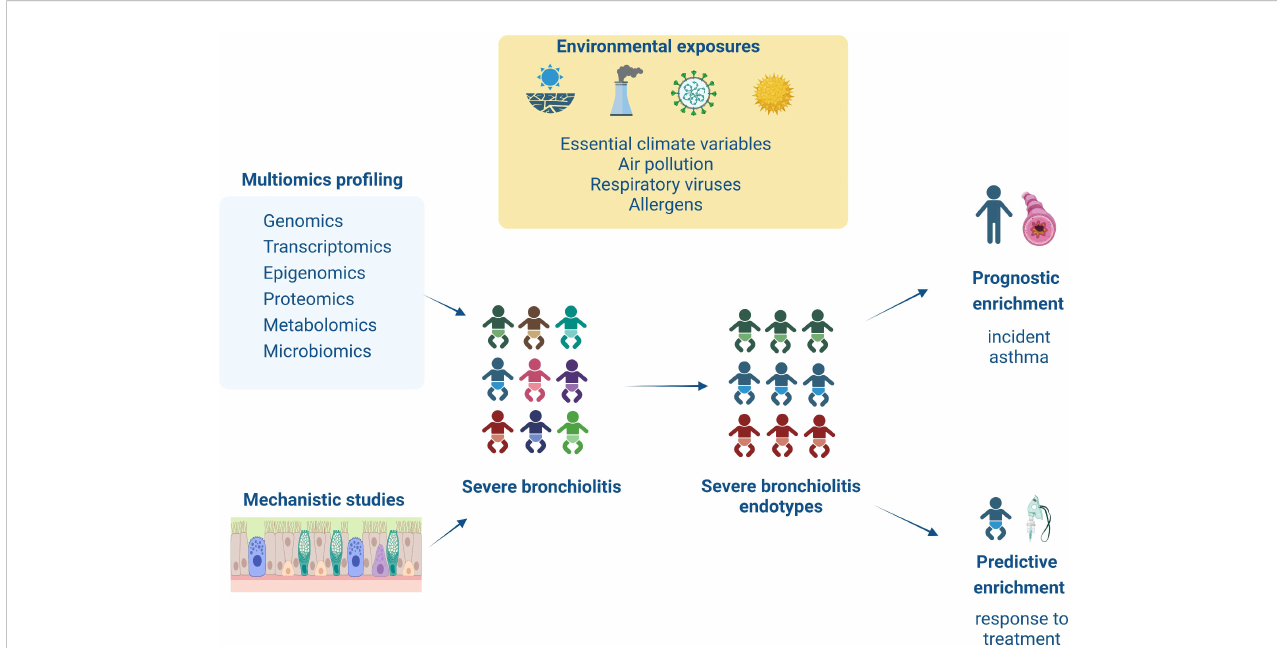
FIGURE 1 This fi gure summarizes the content of the articles collected on this Research Topic. Infants with severe bronchiolitis are at higher risk of having a severe and prolonged hospitalization and long-term respiratory sequelae (i.e., asthma). However, due to increased heterogeneity in clinical presentation and underlying pathology in severe bronchiolitis, we are still missing targeted treatments and sensitive biomarkers for asthma development. This Research Topic presents novel studies utilizing multiomics (i.e., genomic, transcriptomic, epigenomic, proteomic, and metabolomic) or mechanistic (i.e., in/ex vivo , in vitro ) approaches to explore in-depth severe bronchiolitis pathophysiology. These fi ndings help identify severe bronchiolitis endotypes that respond to targeted treatments (i.e., predictive enrichment) or are associated with increased risk for asthma development (i.e., prognostic